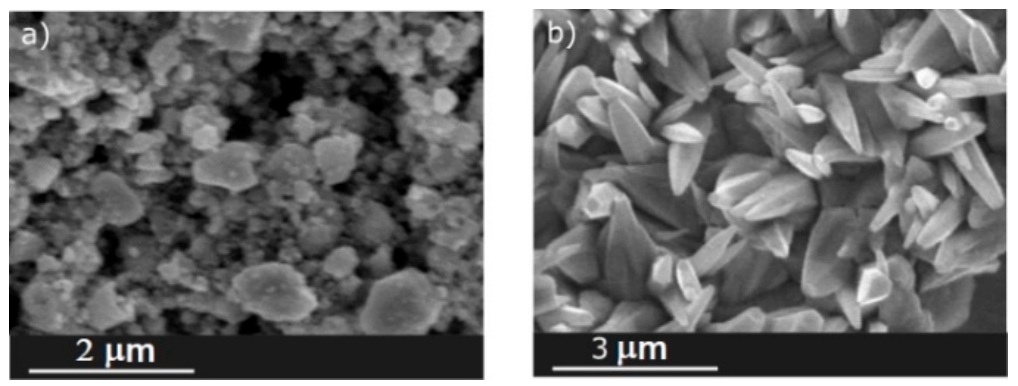
Figure 2. SEM images of ZnO layers formed with the method: ( a ) screen printing; ( b ) chemical bath deposition (CBD).